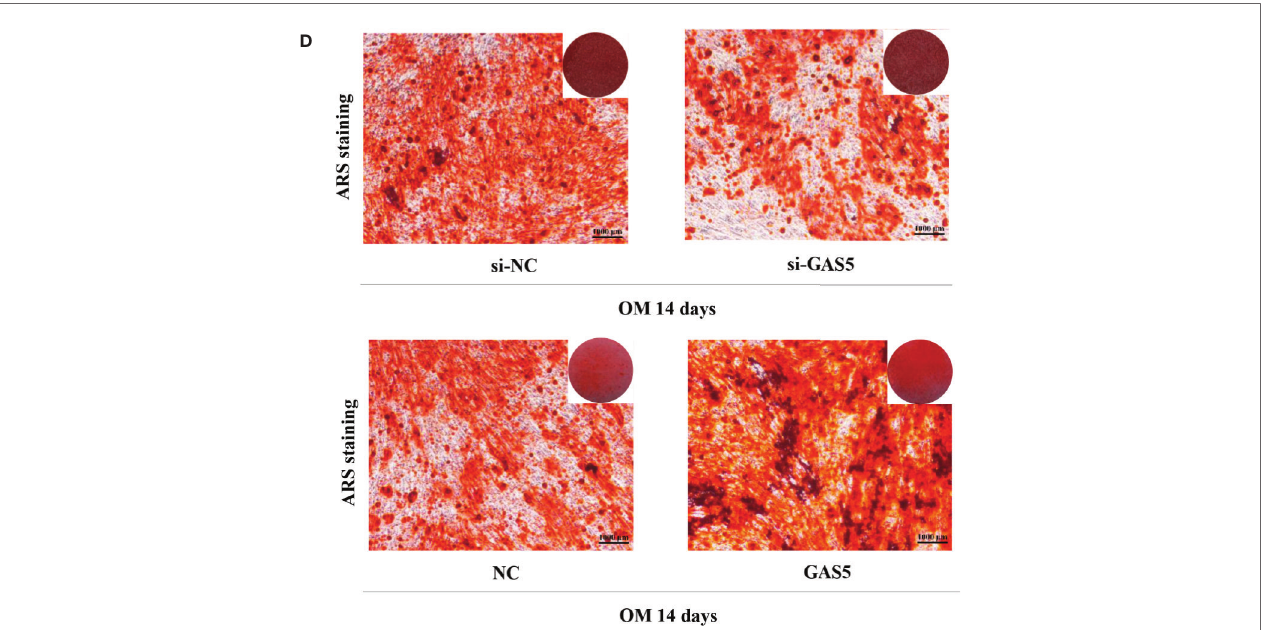
FIGURE 3 | GAS5 enhanced the osteoblast differentiation of hPDLSCs. (A) : The ef fi ciency of transient transduction of si-GAS5 and lentivirus infection is measured by qRT-PCR. The mRNA expression of RUNX2, ALP, OCN was measured in si-NC, si-GAS5, NC and GAS5 group on the second day of osteogenic induction. GAPDH mRNA levels were employed for the process of normalization. (B) : Western blot analysis of the protein expression of RUNX2 and the internal control b - ACTIN on the third day of osteogenic induction. b -ACTIN was utilized for the normalization relative to si-NC groups. (C) : The images of ALP staining in si-NC, si- GAS5, NC and GAS5 group. Cells were cultured in GM or OM for 7 days. (D) : Images of ARS staining that stains for mineralized matrix in the si-NC, si-GAS5, NC and GAS5 group were also cultured in GM or OM for 14 days. *p < 0.05, **p < 0.01. hPDLSCs, human periodontal ligament stem cells; GDF5, growth differentiation factor 5; si-NC, small interfering RNA negative control; si-GAS5, the small interfering RNAs that target GAS5; NC, negative control; GAPDH, glyceraldehyde 3- phosphate dehydrogenase; RUNX2, runt-related transcription factor 2; ALP, alkaline phosphatase; OCN, osteocalcin; GM, growth medium; OM, osteogenic medium; qRT-PCR, quantitative reverse-transcription polymerase chain reaction; ARS, Alizarin red